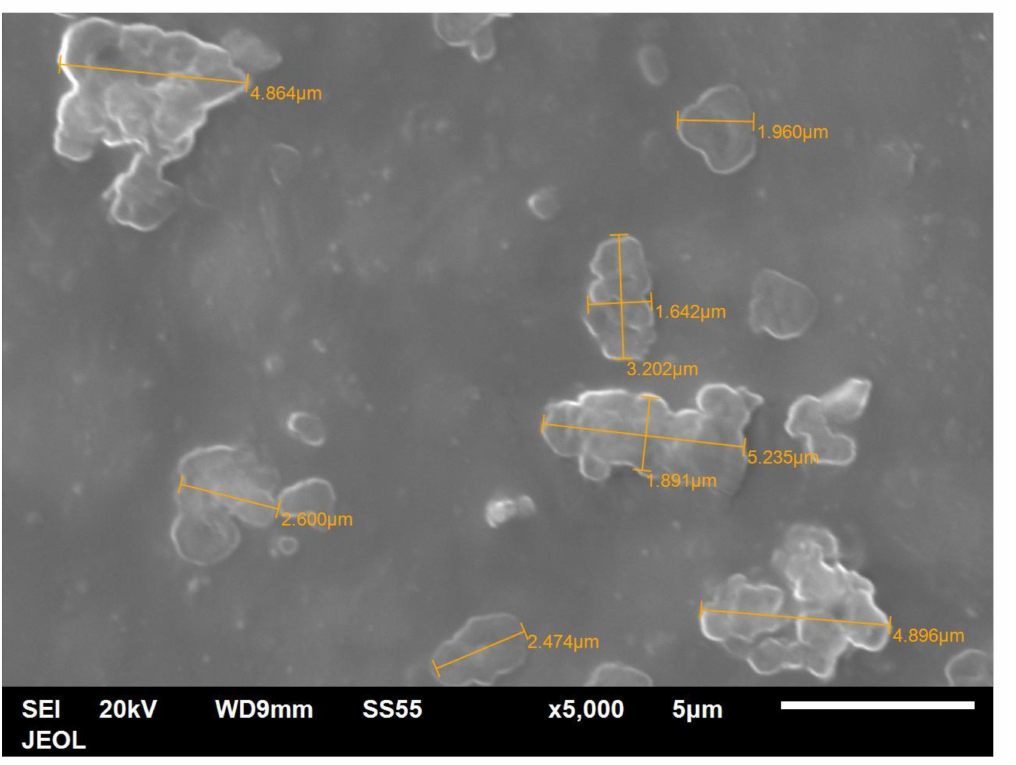
Figure 16. Higher-magnification view of the principal face of the unfractured PET bar with 5 vol.% Al. The Al platelets lie flat and not edgewise. Note the flakes do not have sharp edges, they have rounded corners.